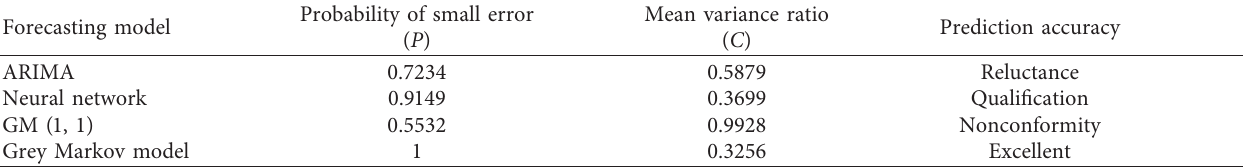
Table 9: Comparison of prediction accuracy between four prediction